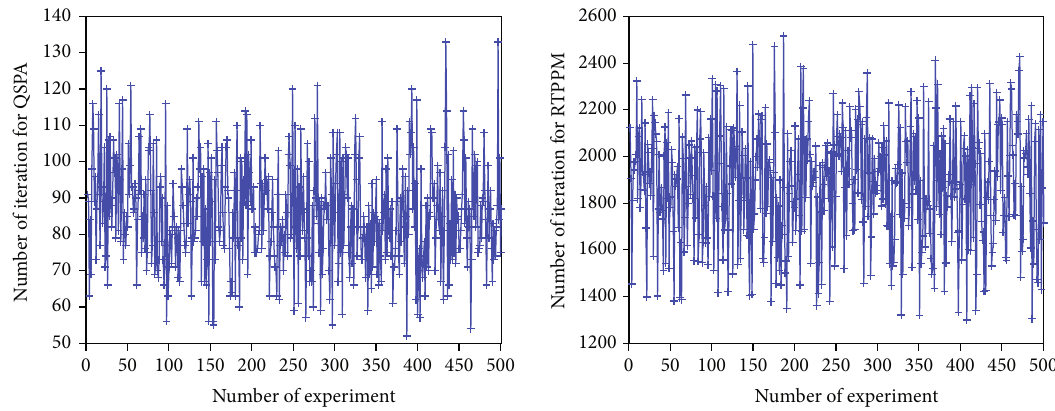
Figure 3: The iteration number of QSPA and